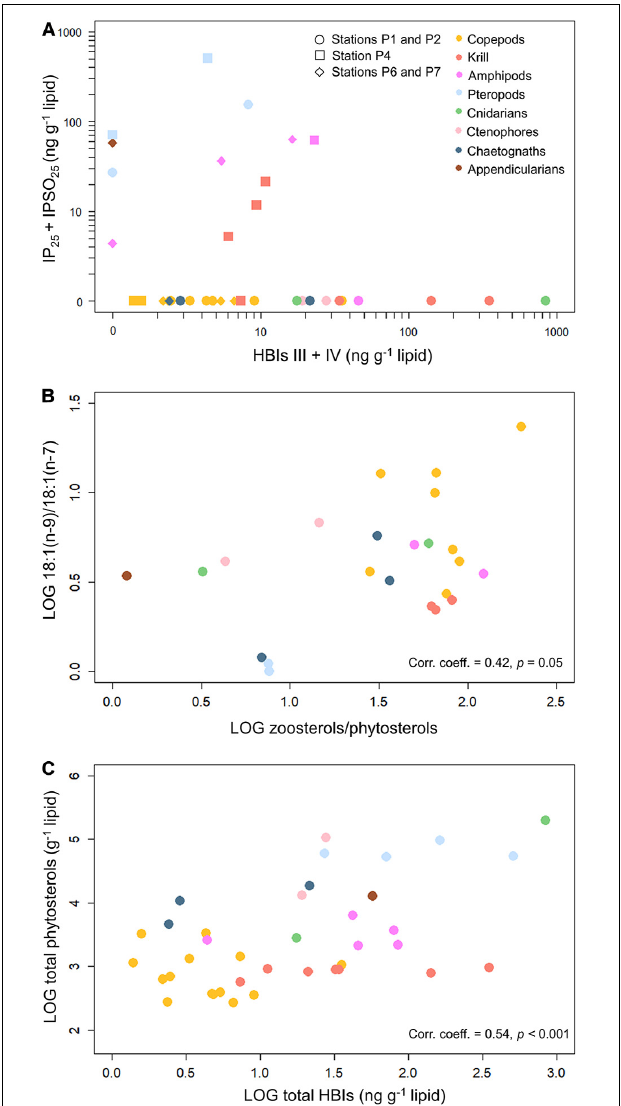
FIGURE 5 | (A) Concentrations of the pelagic/MIZ HBIs III and IV versus the sea ice algae-associated HBIs IP 25 and IPSO 25 in the zooplankton collected during Nansen Legacy cruise Q3 in August 2019 in the Barents Sea. Considered are only samples that contained either pelagic/MIZ or sea ice algae-associated HBIs or both. Datapoints represent individual samples. All data can be found in Supplementary Table 5 . (B) Pearson’s correlation of the mean ratio of zoosterols/phytosterols versus the mean carnivory index 18:1( n –9)/18:1( n –7) in the zooplankton. (C) Pearson’s correlation of total phytosterols versus total HBIs in the zooplankton. Considered are only samples that either contained pelagic/MIZ or sea ice algae-associated HBIs or both. Datapoints represent individual samples.